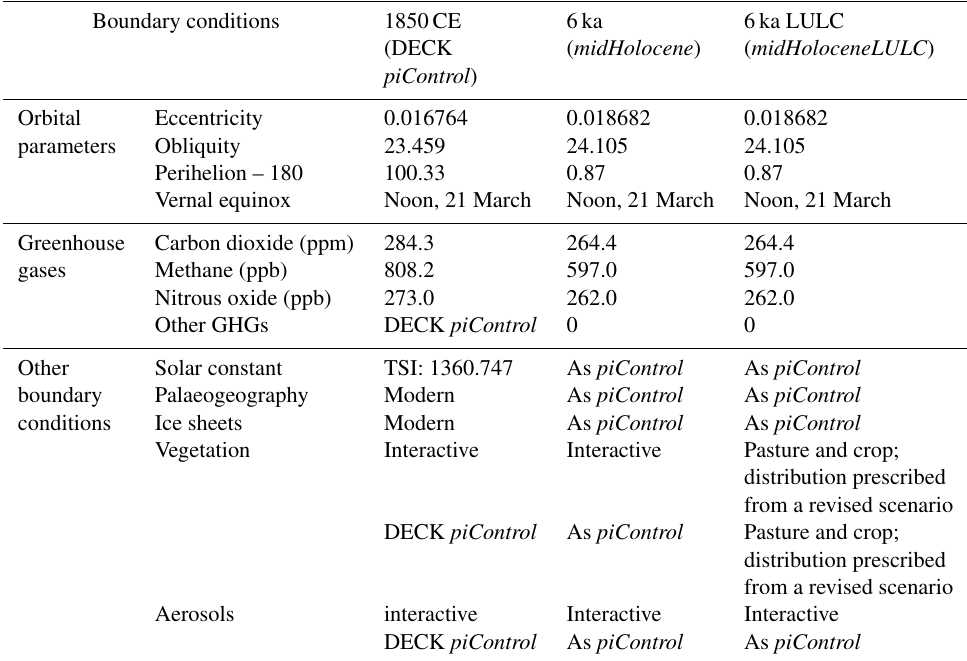
Table 1. Boundary conditions for CMIP6-PMIP4 and the mid-Holocene LULC experiments. The boundary conditions for the CMIP6-PMIP4 piControl and midHolocene are described in Otto-Bleisner et al. (2017) and are given here for